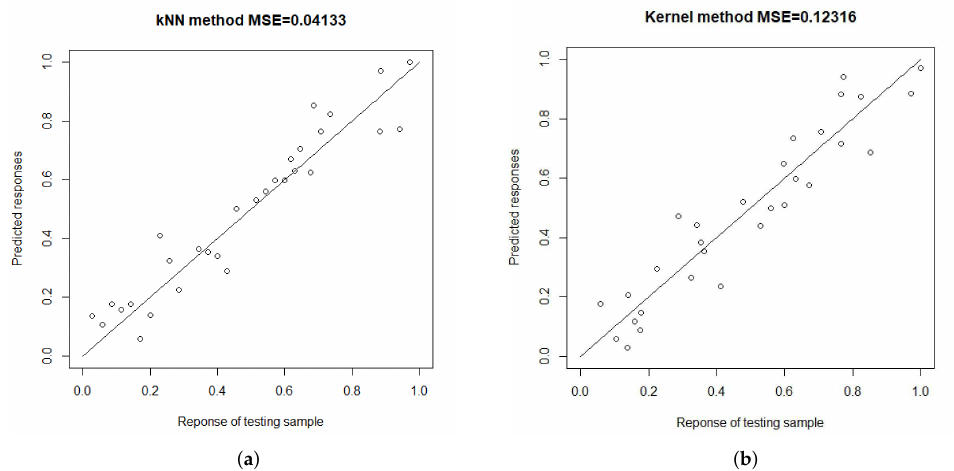
Figure 2. Prediction effects of the two estimation methods. ( a ) kNN estimation method. ( b ) NW estimation method.